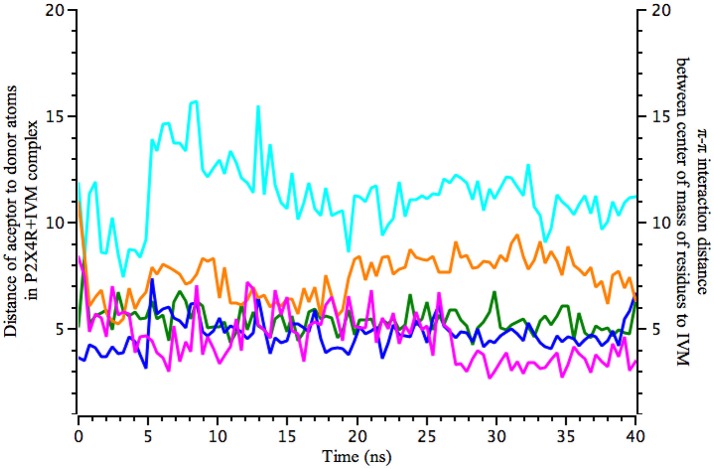
Molecular dynamics calculations show the distance of IVM interaction with P2X4R. Calculated 40 ns MD simulations of IVM interaction with the holo P2X4R. Left y-axis plots the distance (in Å) between acceptor to donor atoms (hydrogen bonds), calculated between O1 of S341 (magenta) with O4 of IVM, and O1 of D331 (orange) with O12 of IVM. Right y-axis refers to possible π-π stacking interactions between W50 (blue sky), W46 (blue), and Y42 (green), calculated between center of mass of the aromatic residues and IVM atoms.